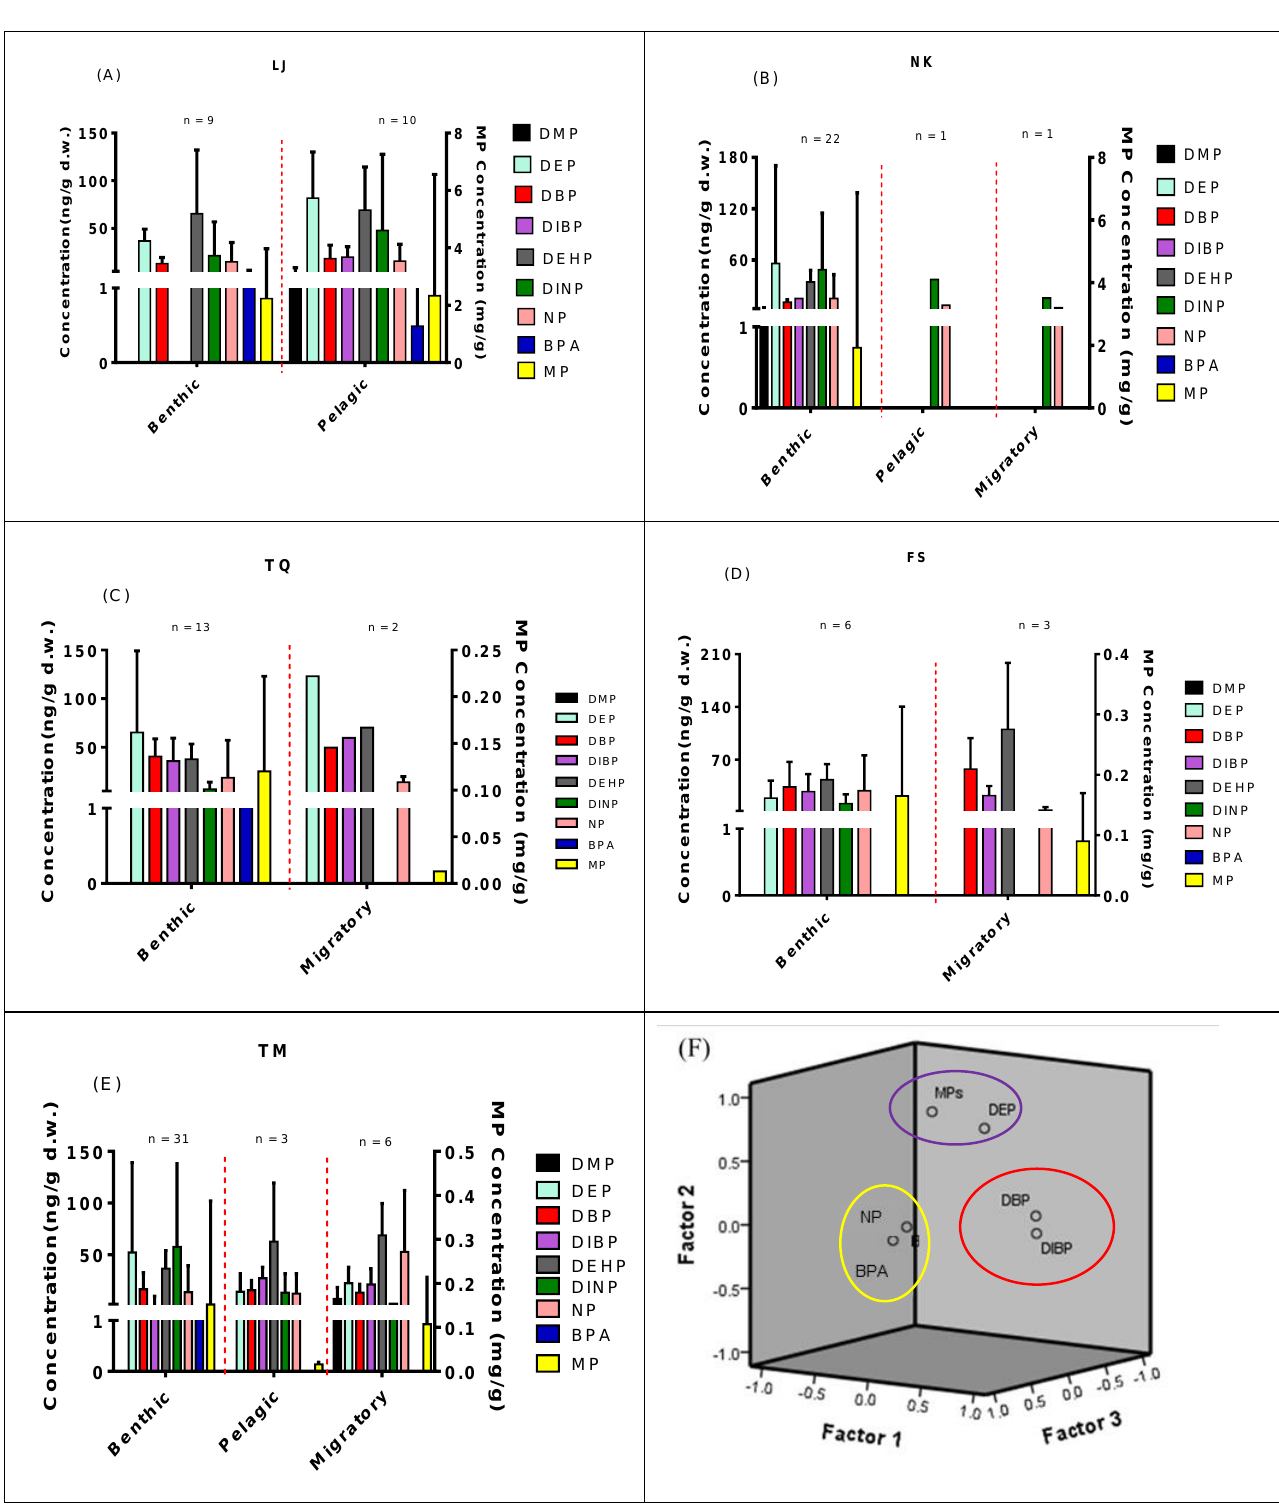
Figure 2. Distribution of EEDCs in estuarine fish samples collected from northern Taiwan. The estuarine fish could be assigned into three groups (benthic, pelagic, and migratory) based on the fish habitat. The estuarine fish levels of PAEs, BPA, NP, and MPs in the estuarine rivers were as follows: ( A ) Lao-Jie (LJ), ( B ) Nankan (NK), ( C ) Touqian (TQ), ( D ) Fengshan (FS), ( E ) Tamsui (TM), and ( F ) Principal component analysis for EEDC residues in the estuarine fish. Table 3 showed the Spearman’s rho correlation coefficients among EEDCs and MPs in 130 pooled samples of estuarine fish. The DEP level in fish were significantly correlated with DBP (r = 0.199, p = 0.023), DINP (r = 0.373, p < 0.001), NP (r = 0.261, p = 0.003), and